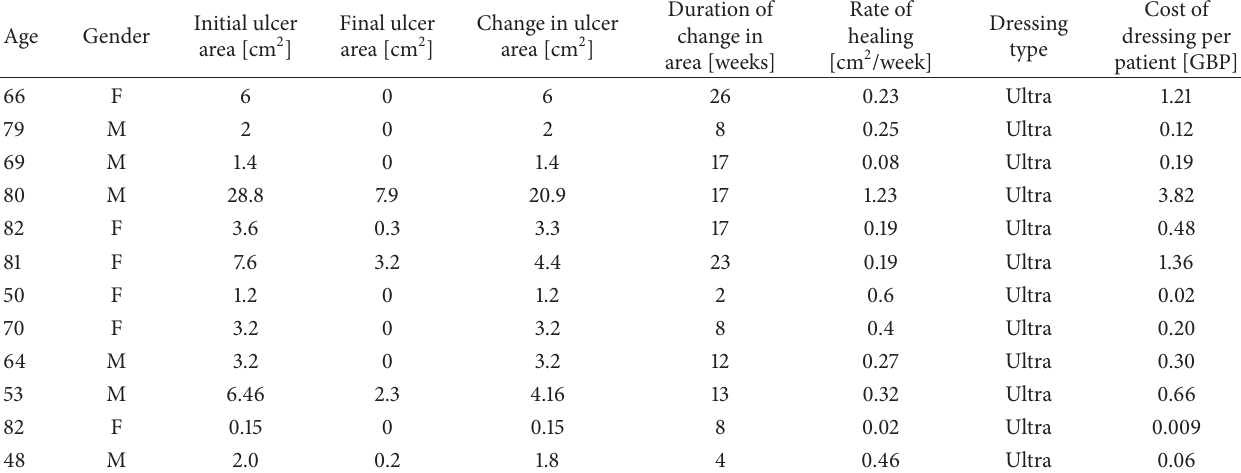
Table 1: Results for simple nonadherent Ultra dressings. The mean healing rate was 0.353 cm 2 /week with a standard deviation of 0.3185 and the mean cost of dressings was 0.702 GBP with a standard deviation of 1.08. The standard error was